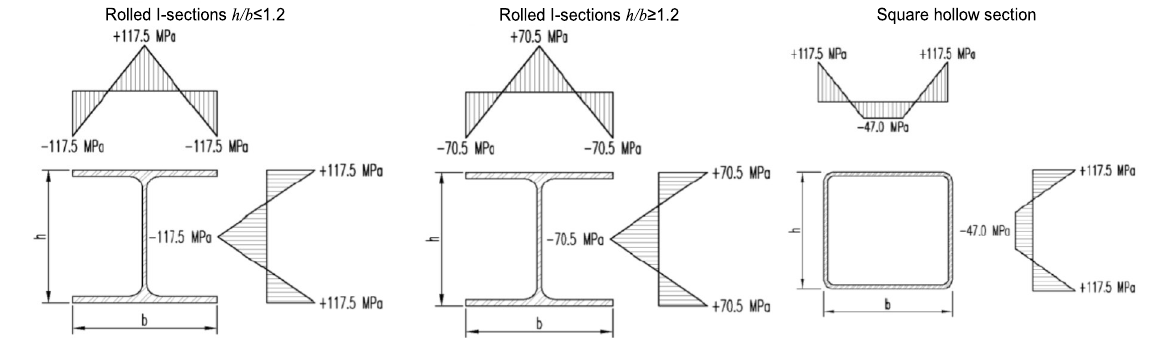
Fig. 1. Residual stress distribution patterns (“–” stands for compression; “+” stands for